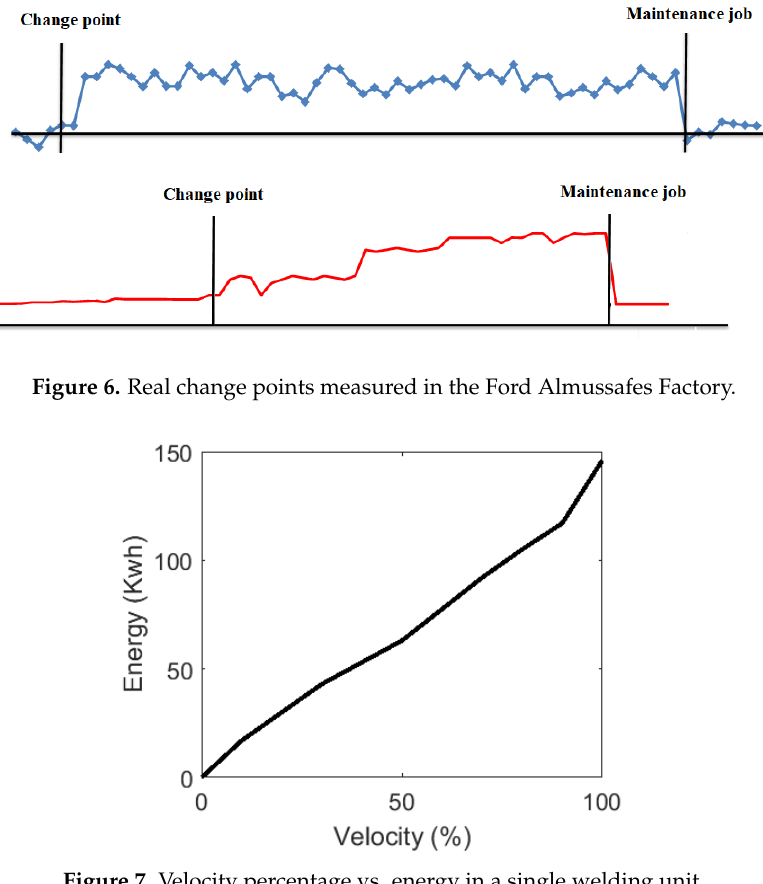
Figure 7. Velocity percentage vs. energy in a single welding